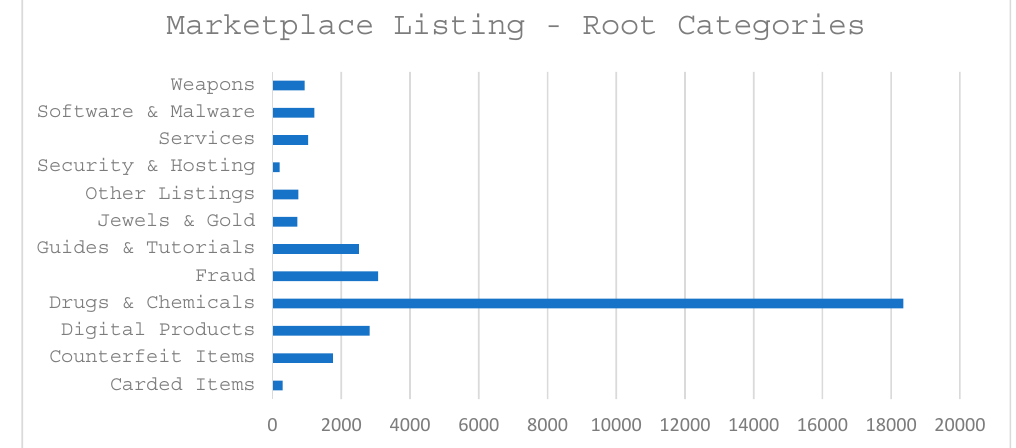
Figure 6. Marketplace Listing—Root Categories.